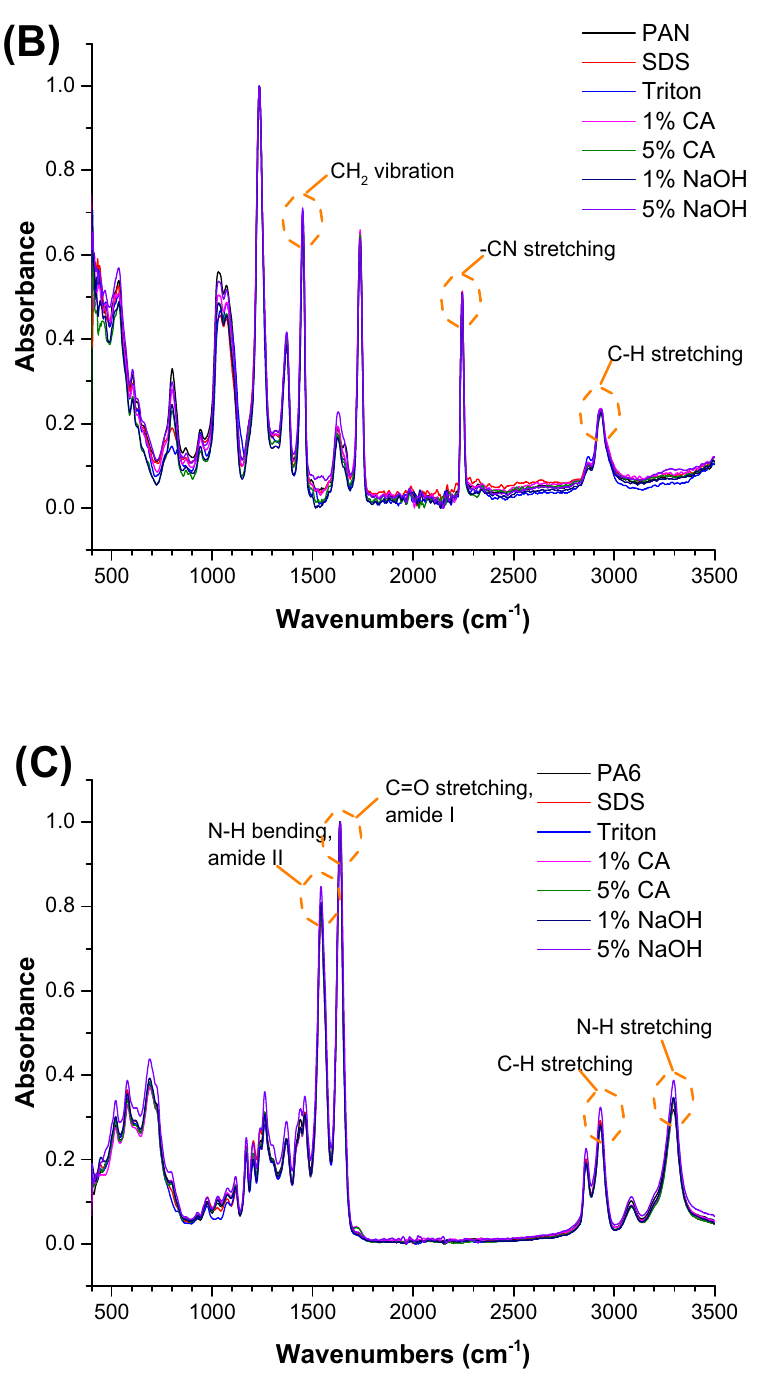
Figure 2. FTIR spectra of the ( A ) PVDF, ( B ) PAN, and ( C ) PA6 membranes before and after the chemical cleaning chemical cleaning process.